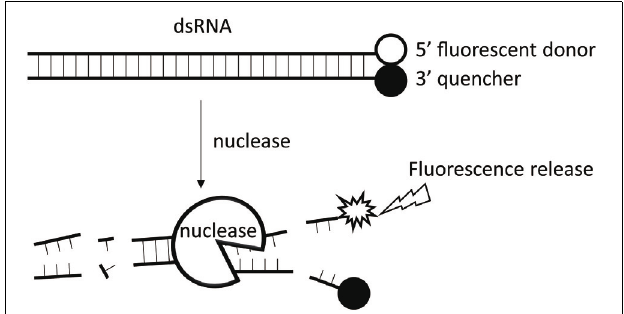
FIGURE 1 | The working principle of the fluorescence method. A 24-bp synthesized dsRNA with a fluorophore group attached to the 3 (cid:48) end of its sense strand and a quencher group to the 5 (cid:48) end of its antisense strand is used as the substrate for analysis of dsRNA nucleases. No fluorescence is emitted when the substrate remain intact as the quencher group inhibits the fluorophore group. When dsRNA nuclease is added to the reaction tube, the dsRNA substrate will be gradually degraded, leading to separation of the fluorophore group from the quencher group, and thus the emission of the corresponding fluorescence light. The more the dsRNA degraded, the stronger the fluorescence